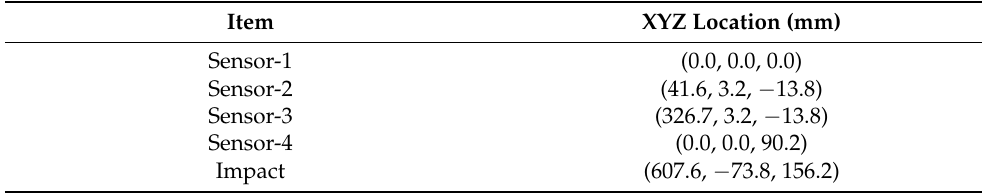
Table 1 listed the exact location of the force hammer and four sensors (strain rosette) in the space coordinate system. Table 1. Location of four sensors (rosette) and impact load (force hammer). Table 1. Location of four sensors (rosette) and impact load (force hammer).